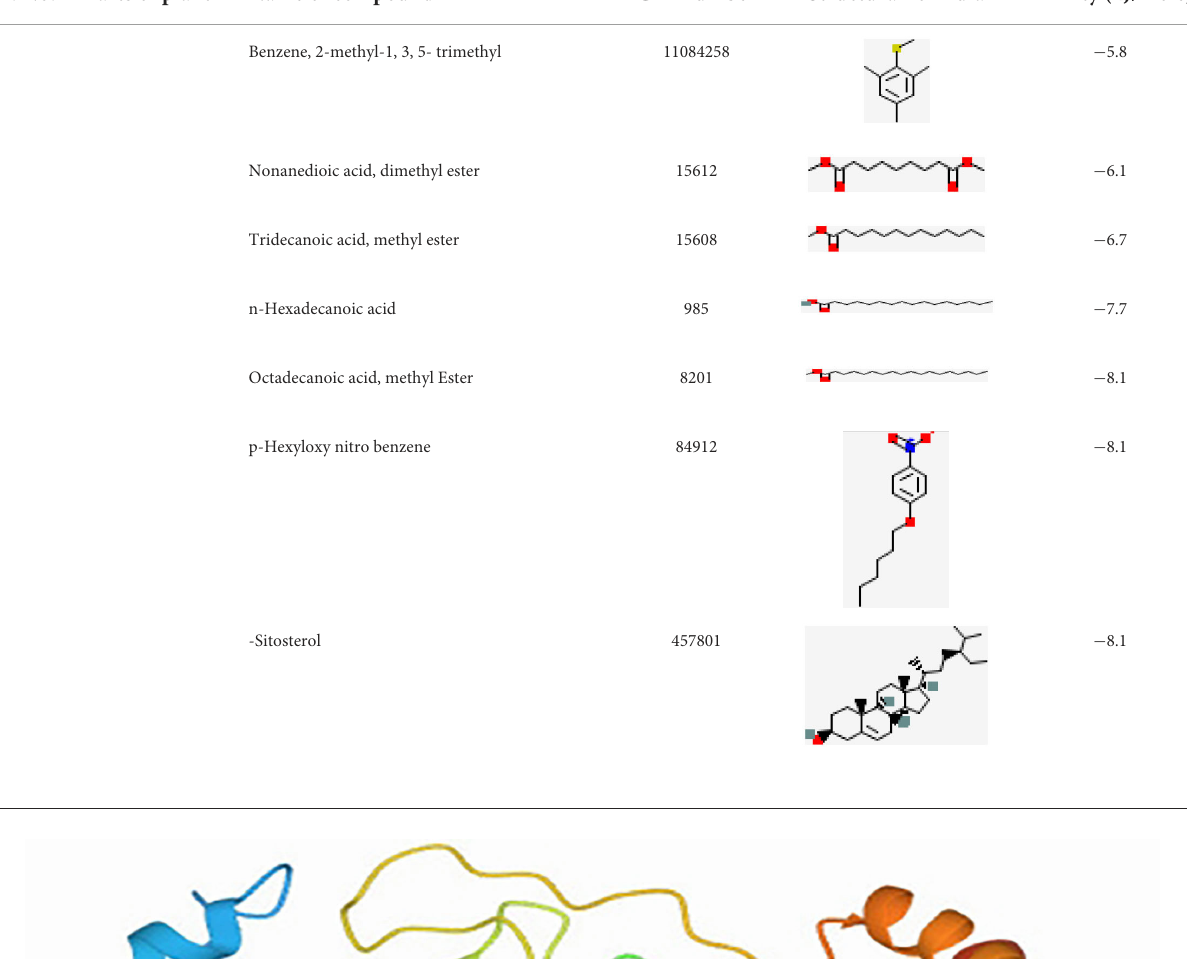
this deadly virus, by which nearly 70,000 people per year are affected (60). A methanolic extract of the roots of